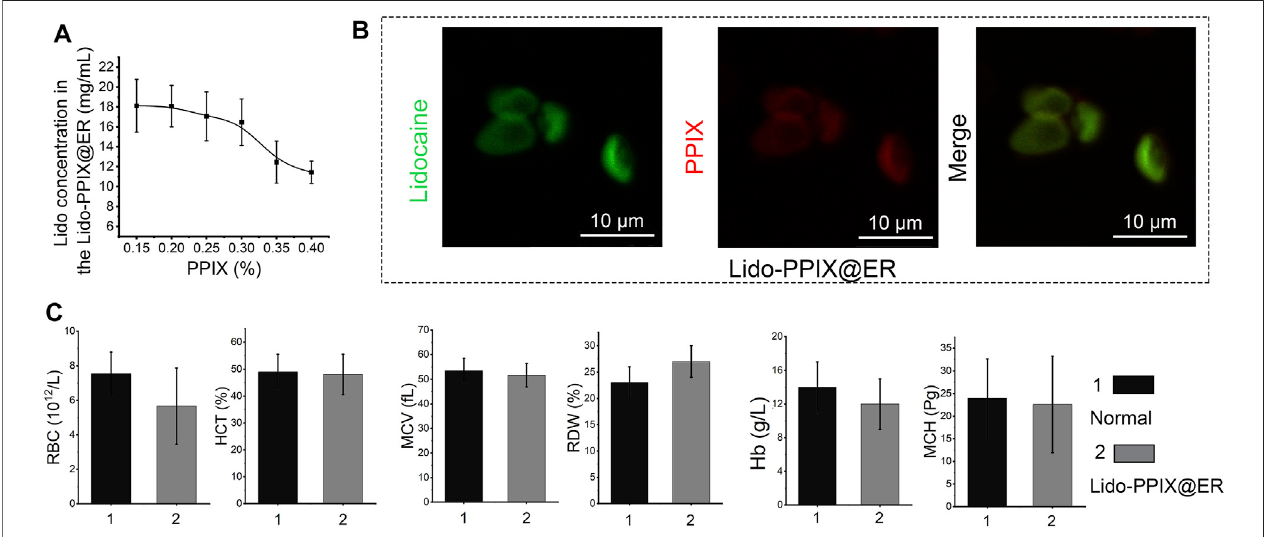
FIGURE 2 | Structure of Lido-PPIX@ER. (A) Relationship between the initial PPIX concentration and loading content. (B) Confocal images of FITC-labeled Lido (green), PPIX (red), and merged fl uorescence. (C) Hematological parameters of normal blood and Lido-PPIX@ER, including red blood cells (RBCs), hematocrit (HCT), mean corpuscular volume (MCV), red cell distribution width (RDW), hemoglobin (Hb), and mean corpuscular hemoglobin